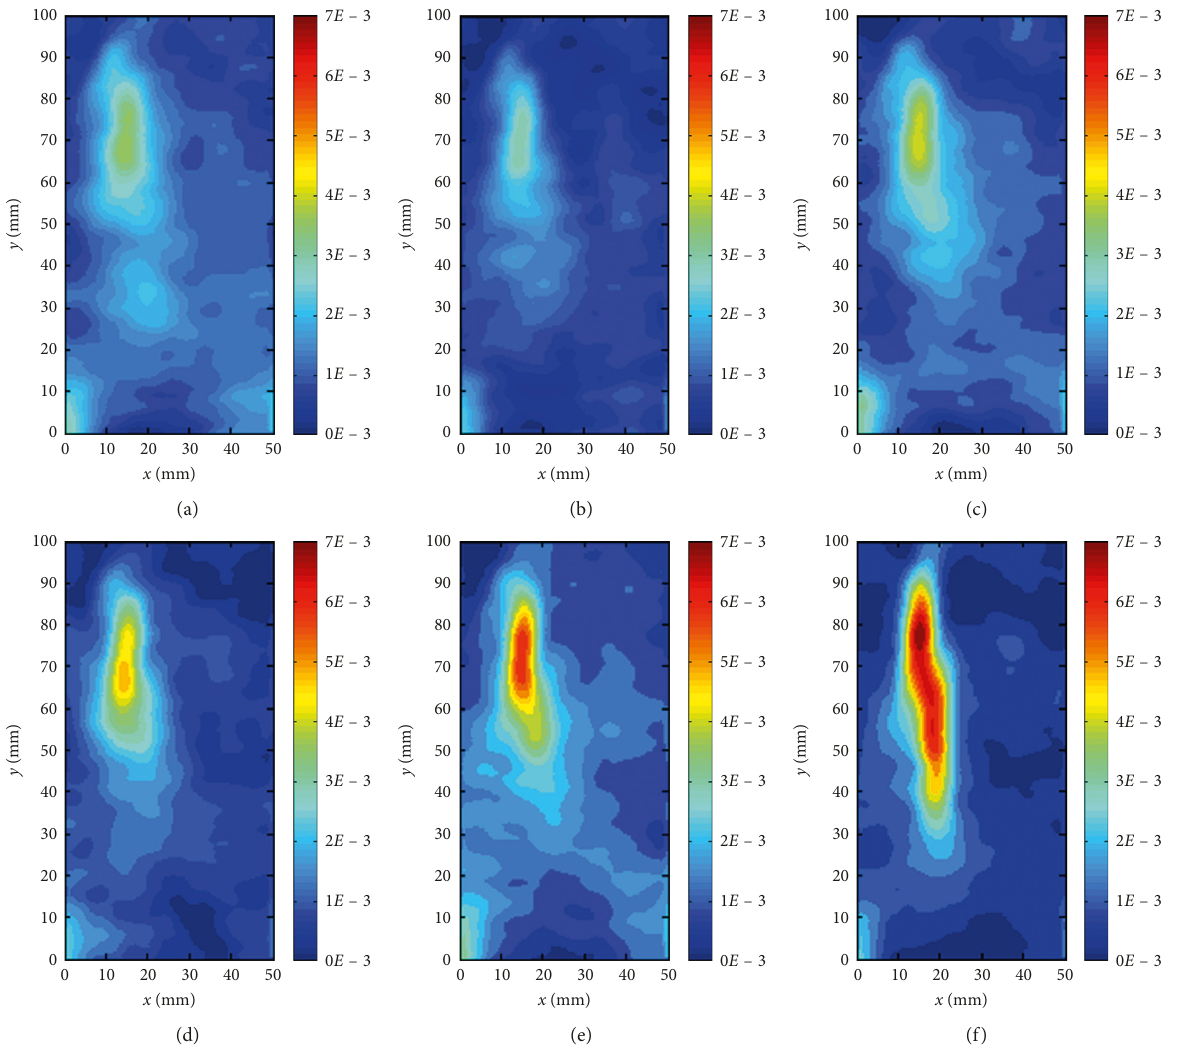
Figure 9: Nephogram of deformation field: (a) PPL at the 15 th cycle; (b) BPU at the 15 th cycle; (c) PPL at the 16 th cycle; (d) BPU at the 16 th cycle; (e) PPL at the 17 th cycle; (f) BPU at the 17 th cycle.